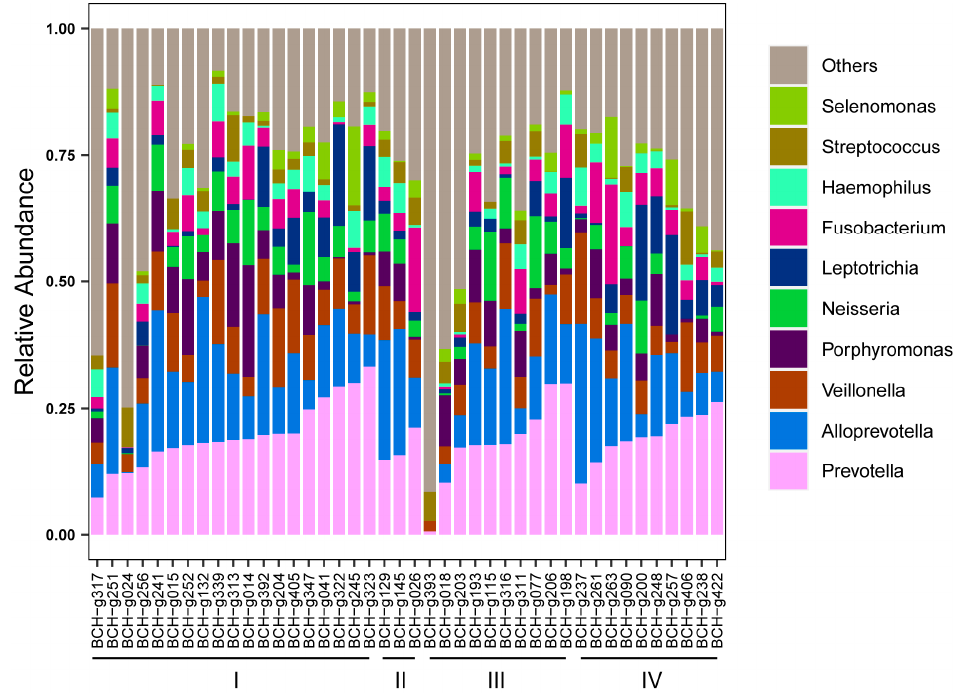
Figure 4. Relative abundance of top 10 genera in the lung microbiota of patients with LADC. The disease staging status in LADC (n = 42) is indicated at the bottom of the figure.